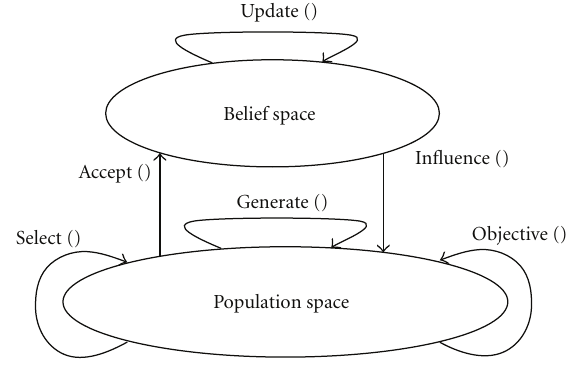
Figure 1: The framework of cultural